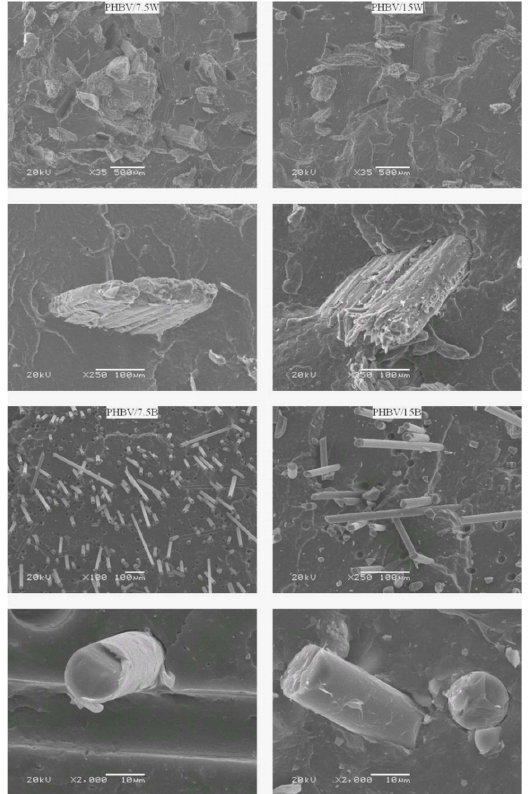
Figure 1. SEM micrographs of poly (3-hydroxybutyrate-co-3-hydroxyvalerate) (PHBV) composites with wood fibers (WF) and basalt fibers (BF).